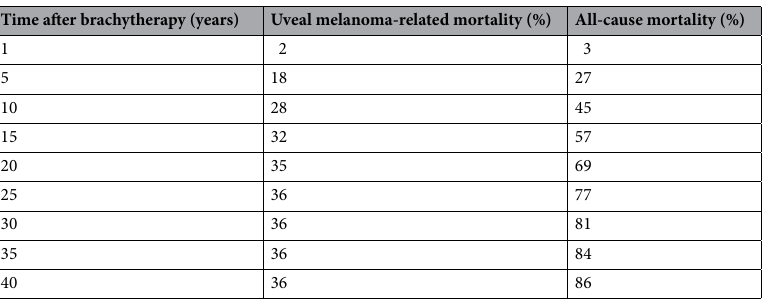
Table 2. Cumulative uveal melanoma-related and all-cause mortality.